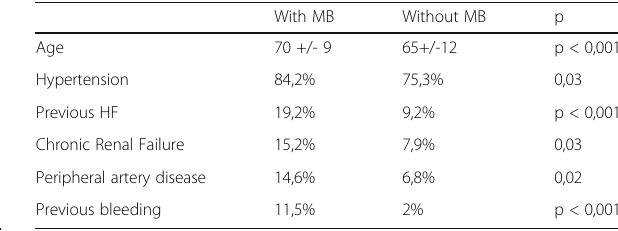
Table 1 (abstract 000535). Clinical